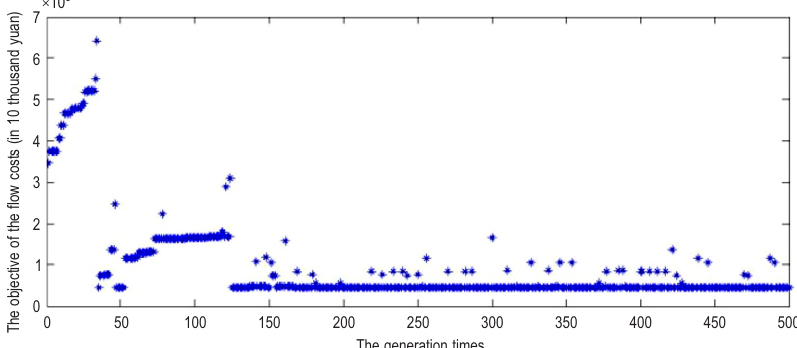
Fig. 7. The searching process of SA-based MOGA Table 7. The comparison of the algorithms Algorithm